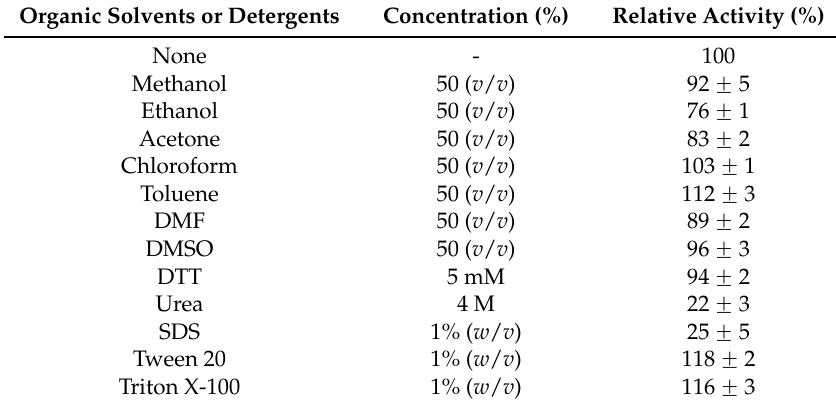
Table 3. Effect of organic solvents and detergents on the synthesis activity of Suc6A of r- Ao FT a .